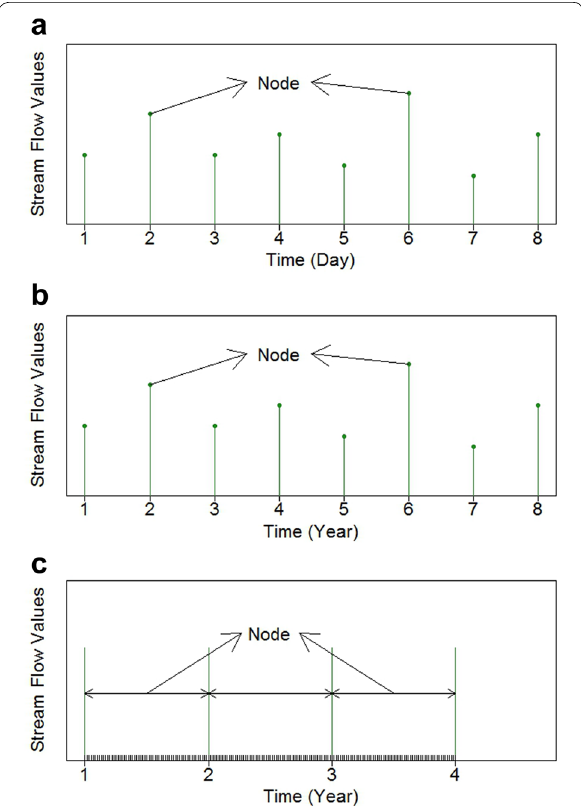
Fig. 2 Network construction for streamflow: a daily network construction using daily data; b annual network construction using annual data; and c annual network construction using daily